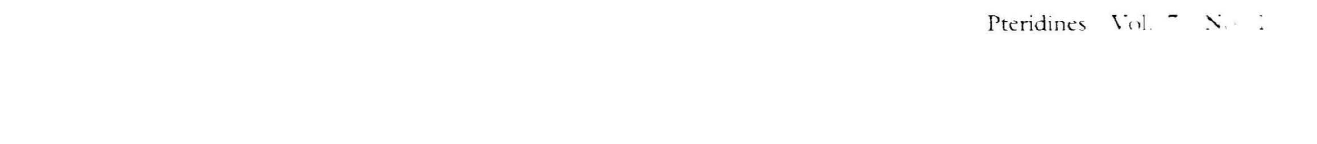
Yang el al.: Mouse dihydropteridine reductase cDNA sequence and comparison